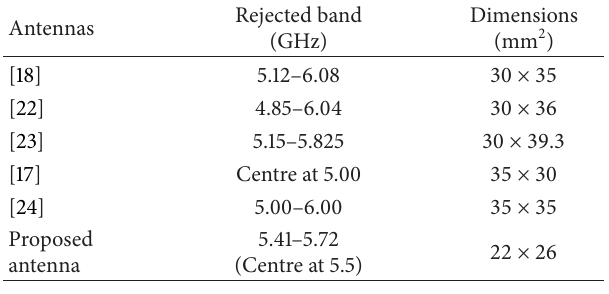
Table1:Comparisonsbetweenexistingandproposedband-rejected UWB antennas.